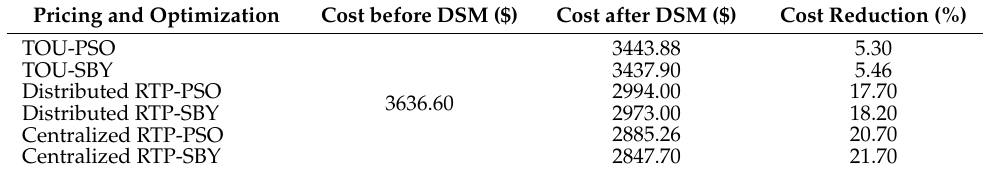
Table 7. Comparison of DSM with the TOU and RTP pricing for the commercial area.